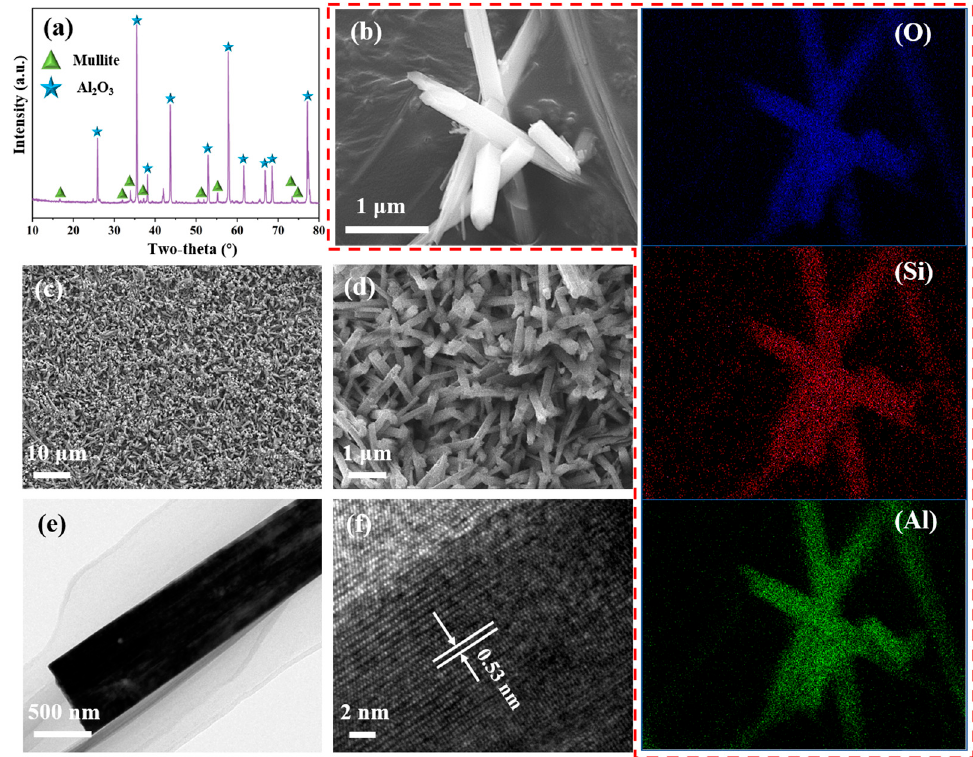
Figure 4. ( a ) XRD pattern of ceramic samples treated with molten salt; ( b ) SEM and EDS of